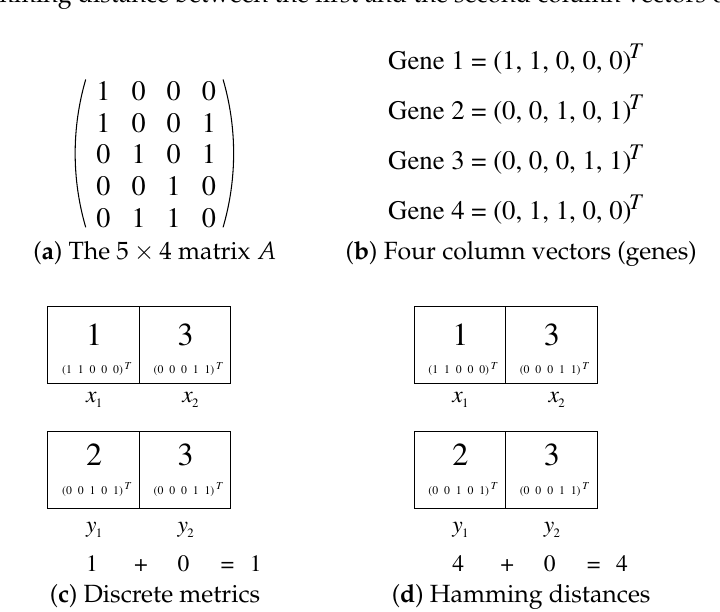
Figure 1. Discrete metric vs. Hamming distance, for the chromosomes (1,3) and